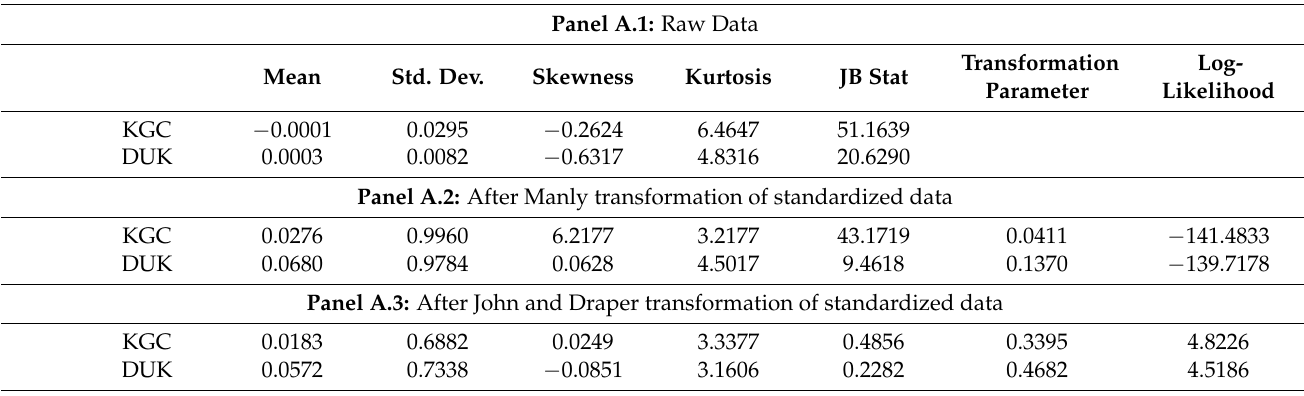
Panel A.3: After John and Draper transformation of standardized data